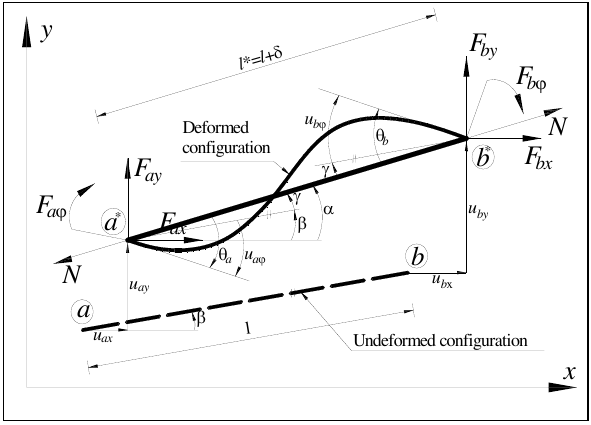
Fig 1. Member end forces and displacements in global coordinates The fundamental member-forces quantities M , N and distortion quantities b